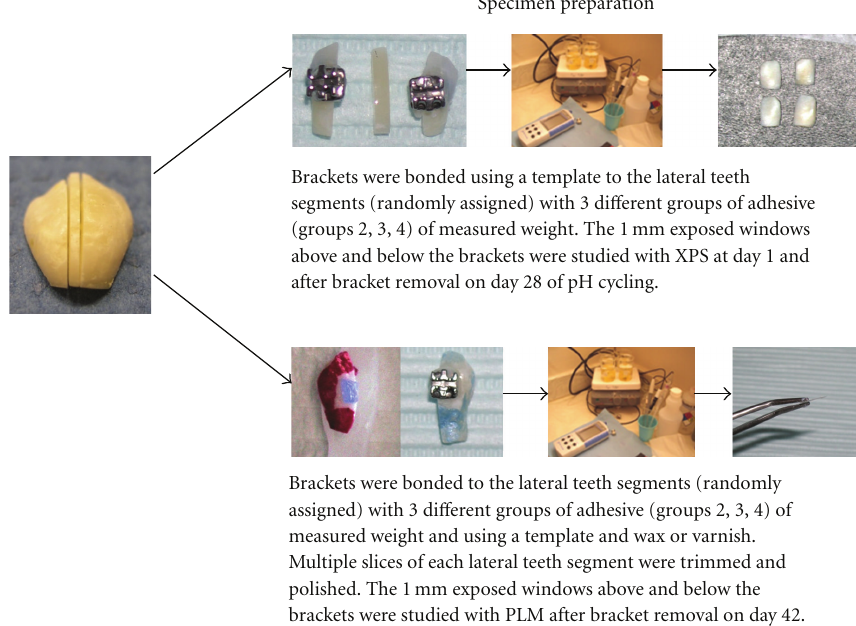
Figure 1: Details of specimen